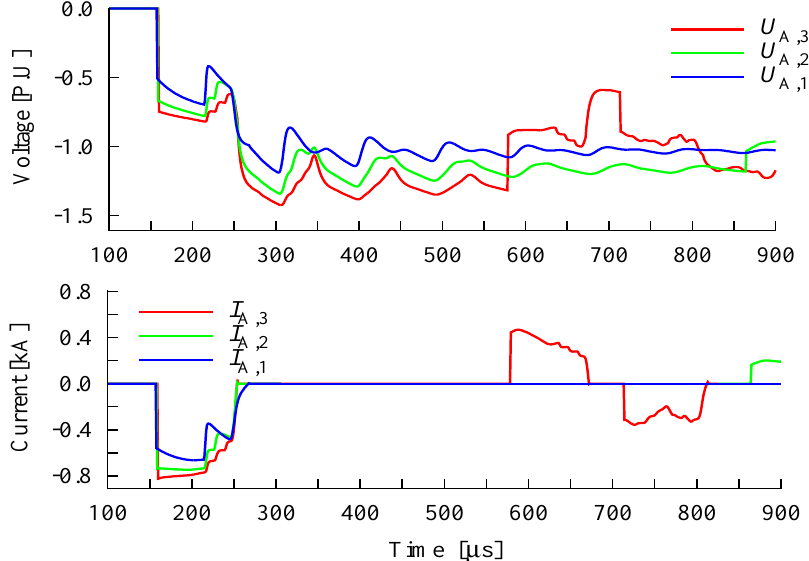
Figure 9. Simulated platform voltages and currents for the three study cases for phase A. Label numbering corresponds to the number or radials connected when radial A is being